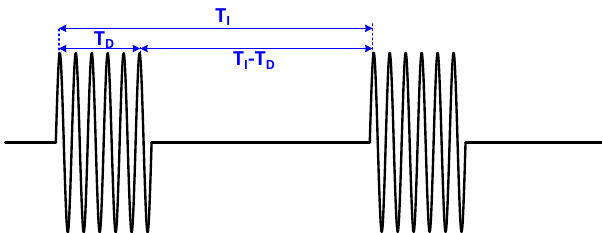
Figure 2. Duty-cycled waveform with indications of the duty cycle interval T I and the active duty period T D